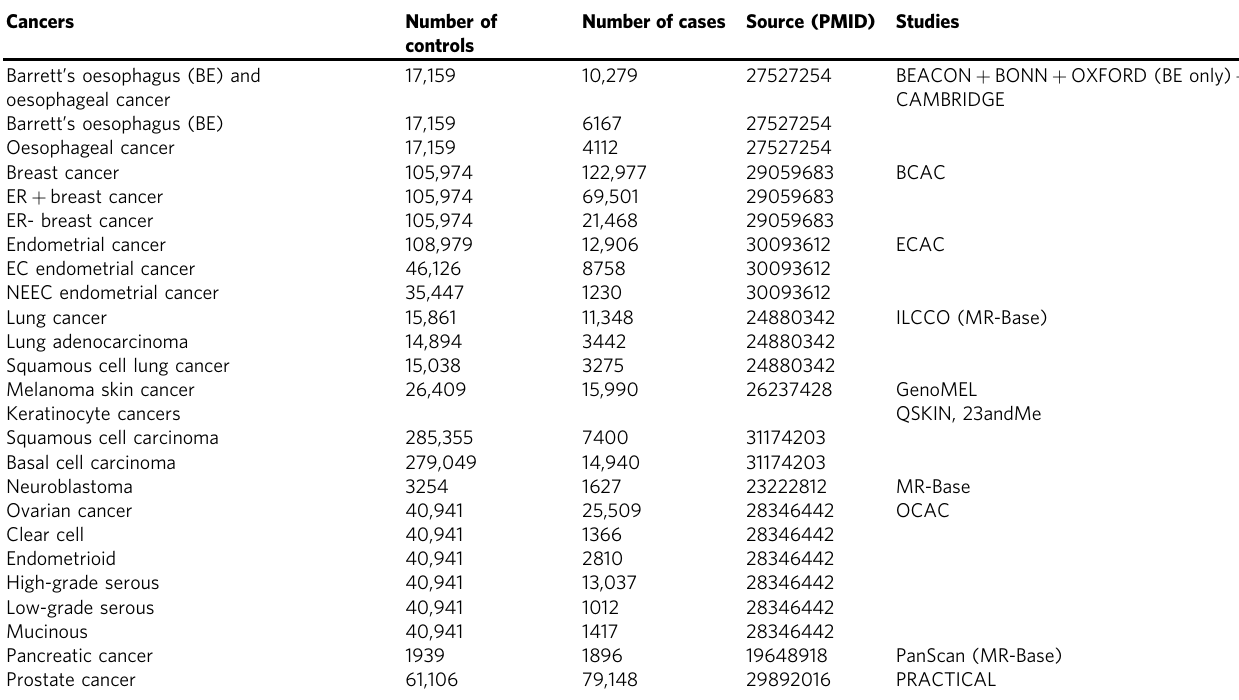
Table 1 Distribution of cases and controls available for the vitamin D and cancer risk MR analysis using summary statistics from various